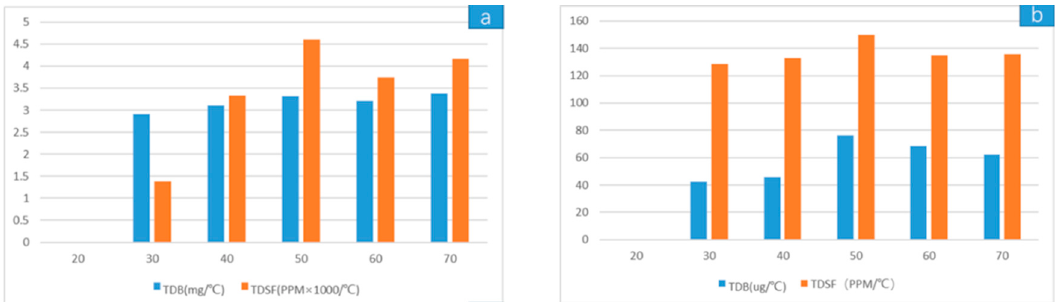
Figure 22. The test results of the scale factor drift and the bias drift before and after packaging: ( a ) the relationship between the scale factor drift and the temperature before packaging; ( b ) the relationship between the bias drift and the temperature before packaging; ( c ) the relationship between the scale factor drift and the temperature after packaging; ( d ) the relationship between the bias drift and the temperature after packaging.